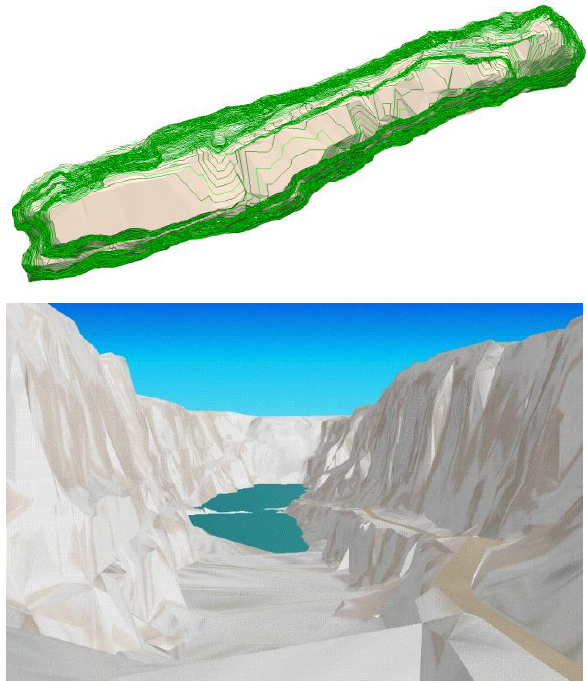
Figure 3. DTM created in 1994 using software Atlas DMT.